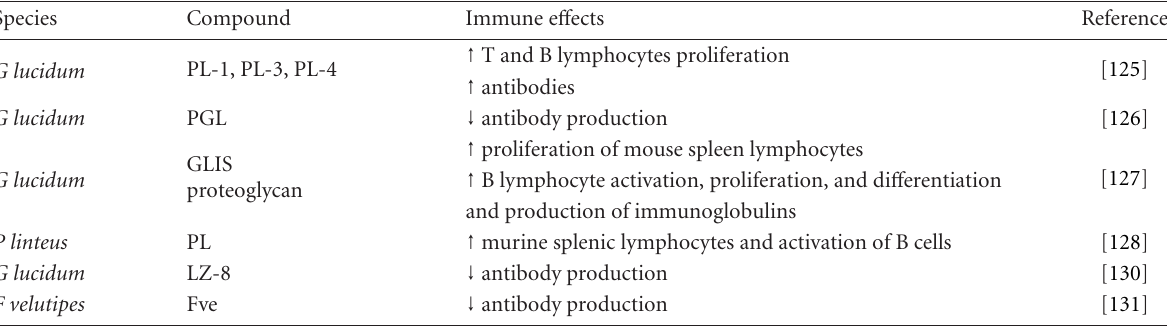
Table 7. Immunomodulatory activities of mushroom compounds on B